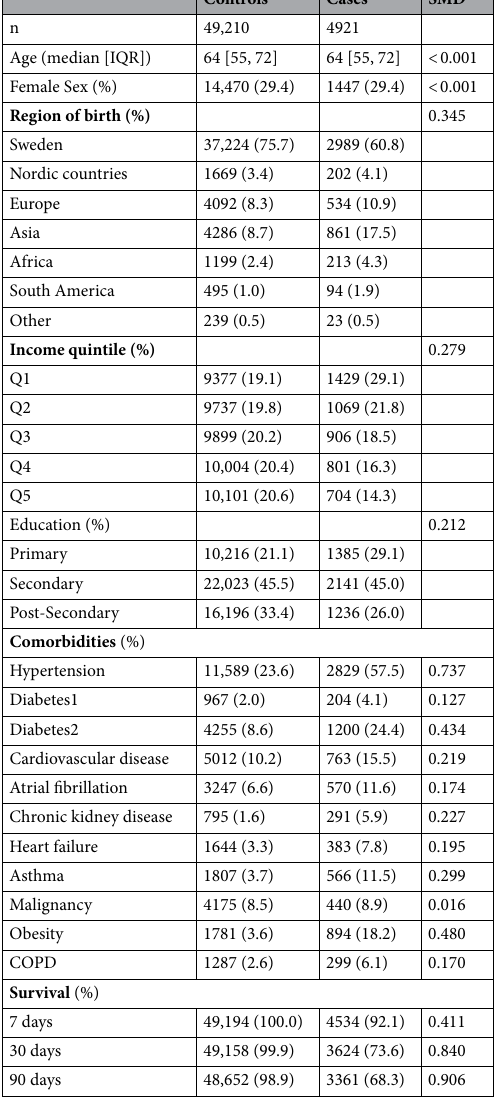
Table 1. Baseline characteristics and outcome of cases and population controls. SMD standard mean deviation; Q quintile; COPD chronic obstructive pulmonary